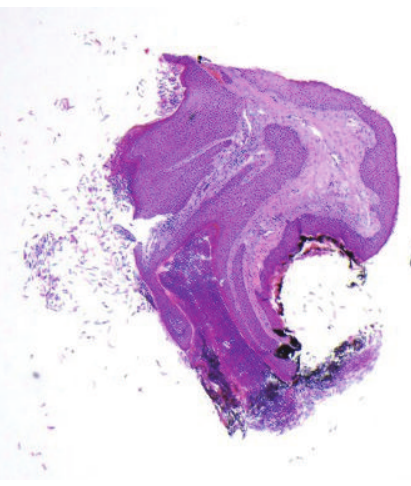
Figure 1: Low power view of the initial biopsy (HE, 4x).